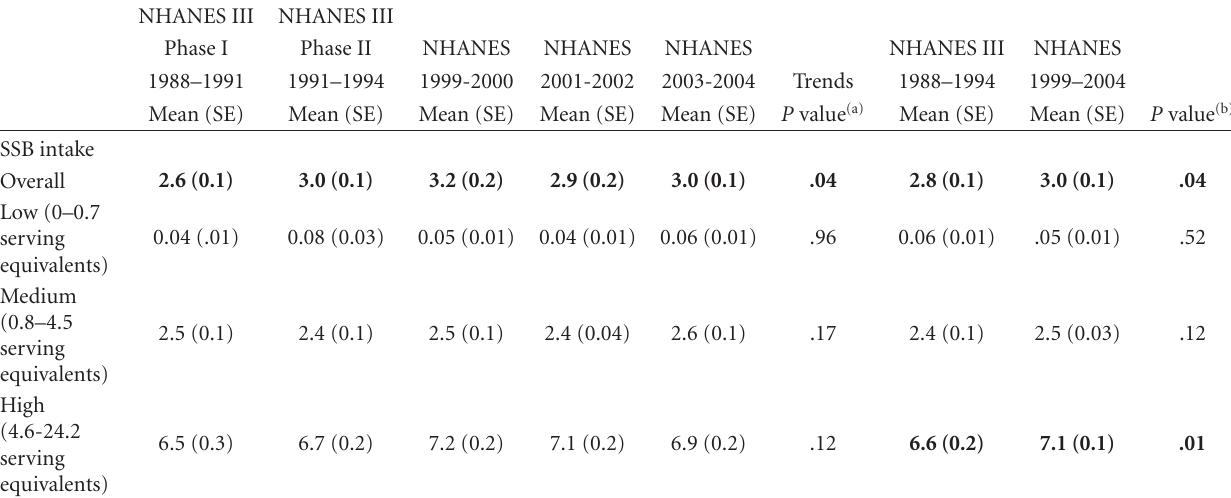
Table 2: Trends in SSB intake among adolescents aged 12–19 years: NHANES III (1988–1994), NHANES 1999-2000, NHANES 2001-2002, and NHANES 2003-2004. Low SSB intake defined as lowest quintile based on NHANES III cuto ff s; medium defined as 2nd–4th quintiles; high defined as highest quintile. Mean indicates mean number of serving equivalents of sugar-sweetened beverages reported during 24 hour dietary recall. Significant results are in bold . Abbreviations: SSB, sugar-sweetened beverage; SE, standard